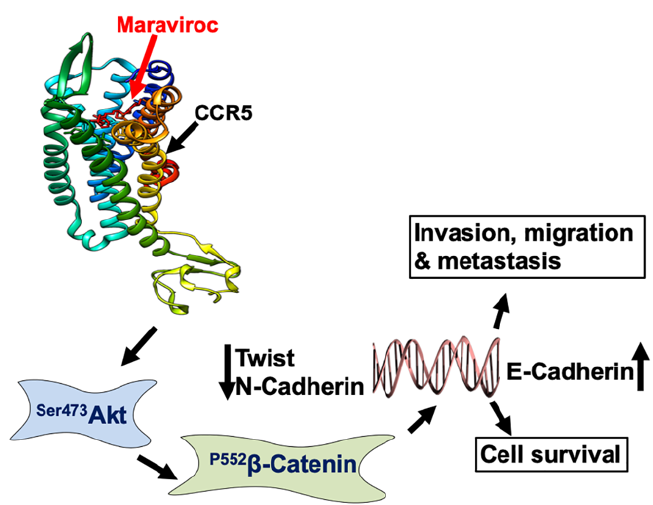
Figure 8. Schematic representation of the CCR5/CCL5 interaction inducing cell survival, invasion, migration, and metastasis. Crystal structure (PDB id: 4mbps) depicting a CCR5/CCL5 interaction that activates the Akt-1 downstream pathway to promote the migration and invasion of LCa